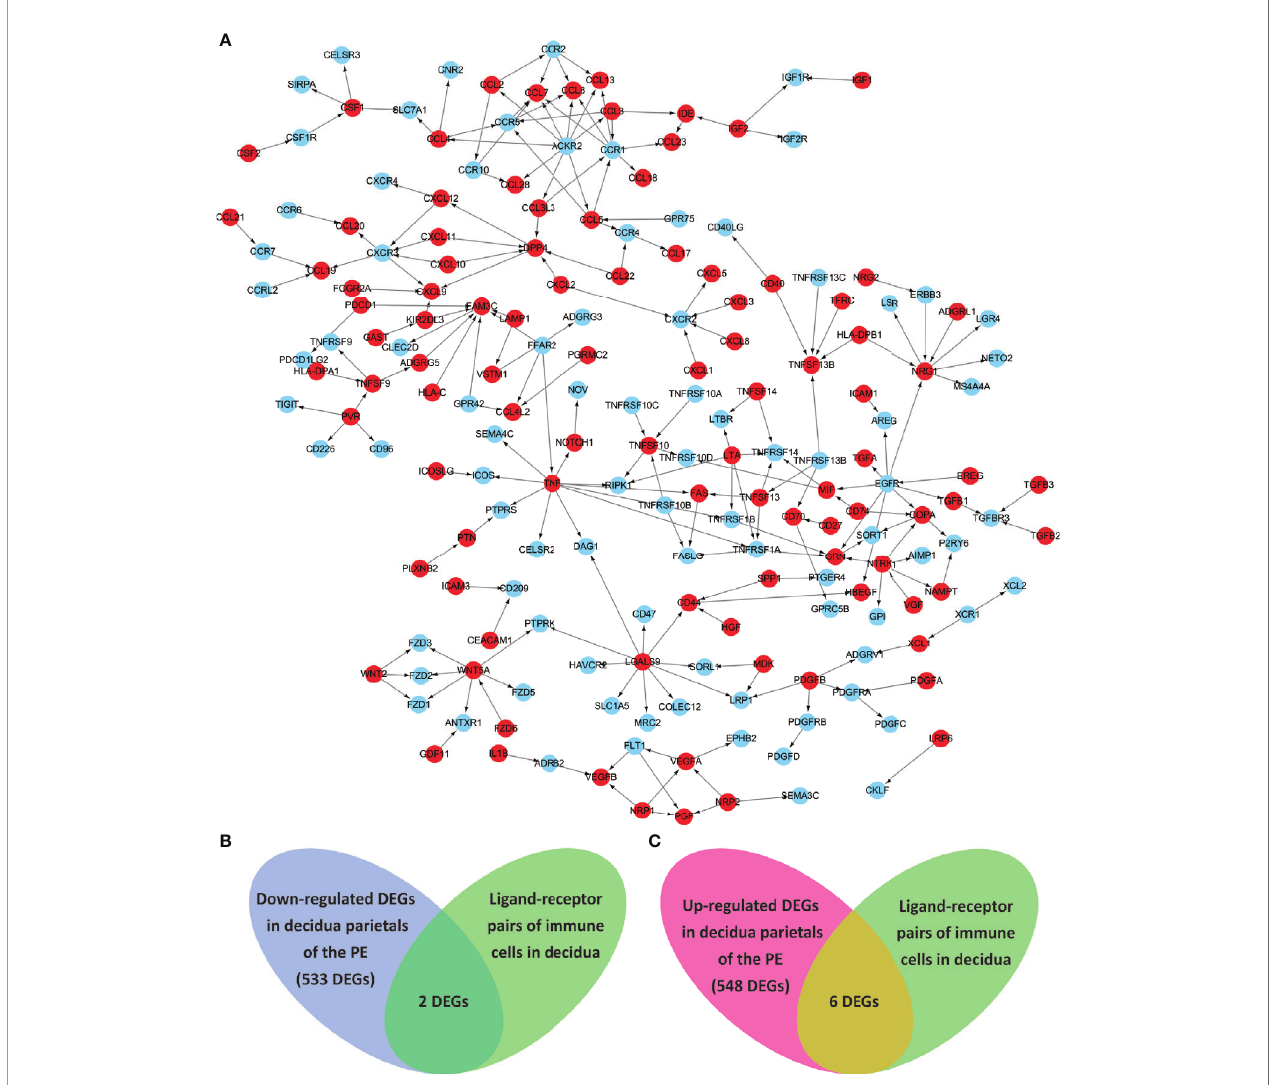
FIGURE 2 | The ligand-receptor relationships of the differentially expressed genes (DEGs) in the decidua parietalis of PE. (A) The ligand-receptor signaling network of immune cells in deciduas. Red dots represent ligands and blue dots represent receptors. The arrows points from ligands to receptors. (B) Venn diagrams of the signi fi cantly down-regulated DEGs in the decidua parietalis of the PE and in the ligand-receptor pairs of immune cells in deciduas. (C) Venn diagrams of the signi fi cantly up-regulated DEGs in the decidua parietalis of the PE and in the ligand-receptor pairs of immune cells in